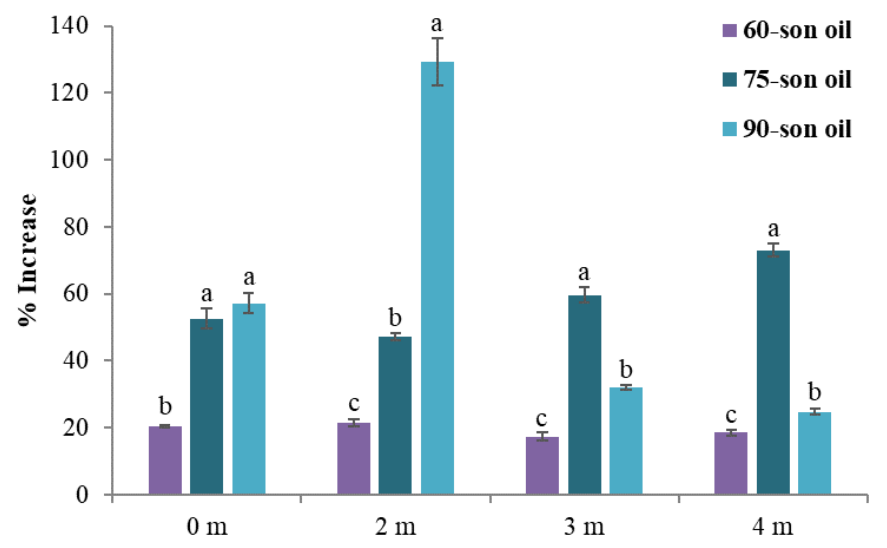
Figure 6. Total polyphenols in samples of 60 ‐ , 75 ‐ , and 90 ‐ son olive oils; Standard deviations are presented with error bars and means within each month with different superscript letters (e.g., a– d) are significantly ( p < 0.05) different.